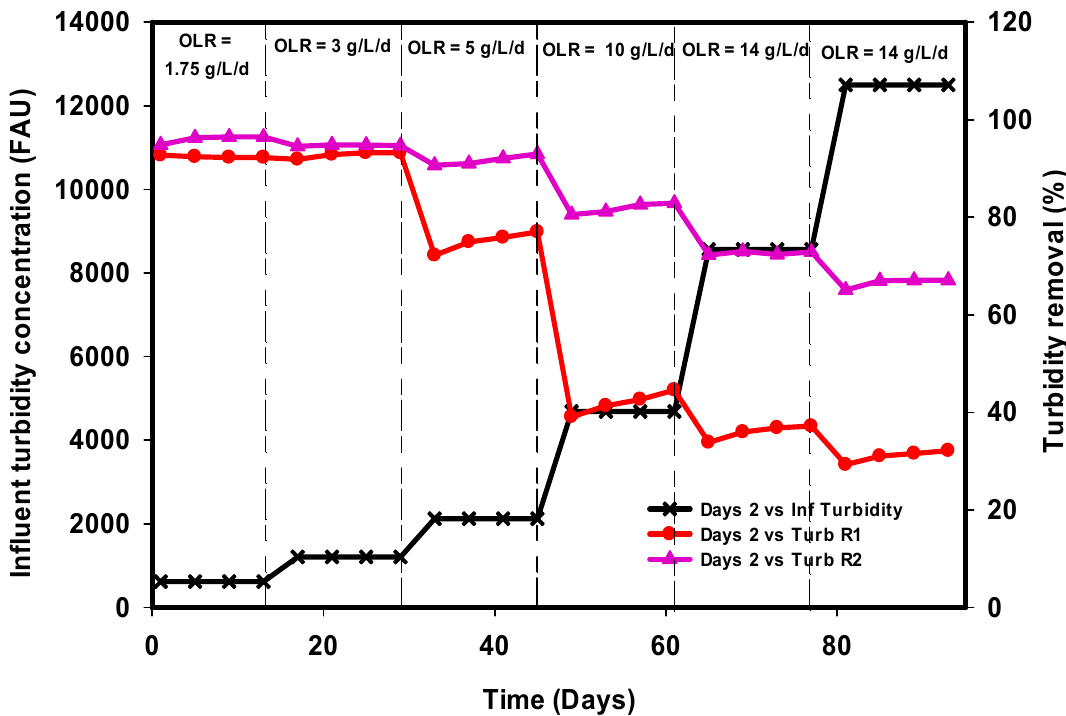
Figure 8. Comparison of turbidity removal efficiencies of R1 and R2.